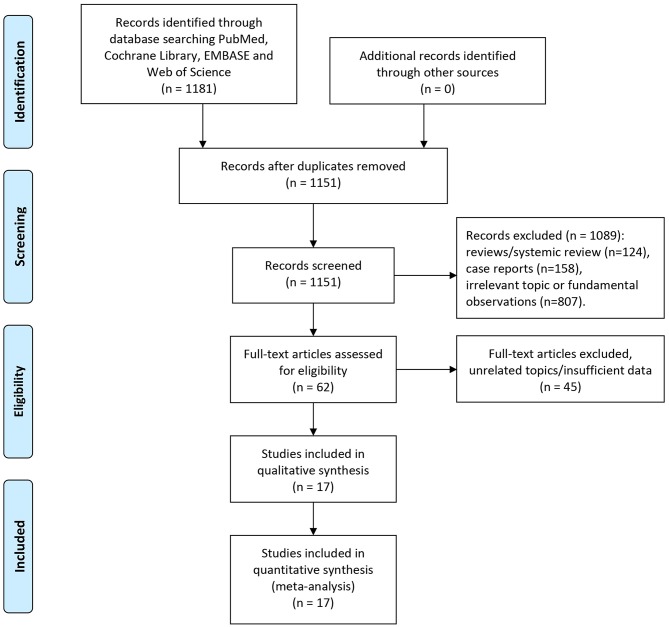
Flow diagram of study selection.